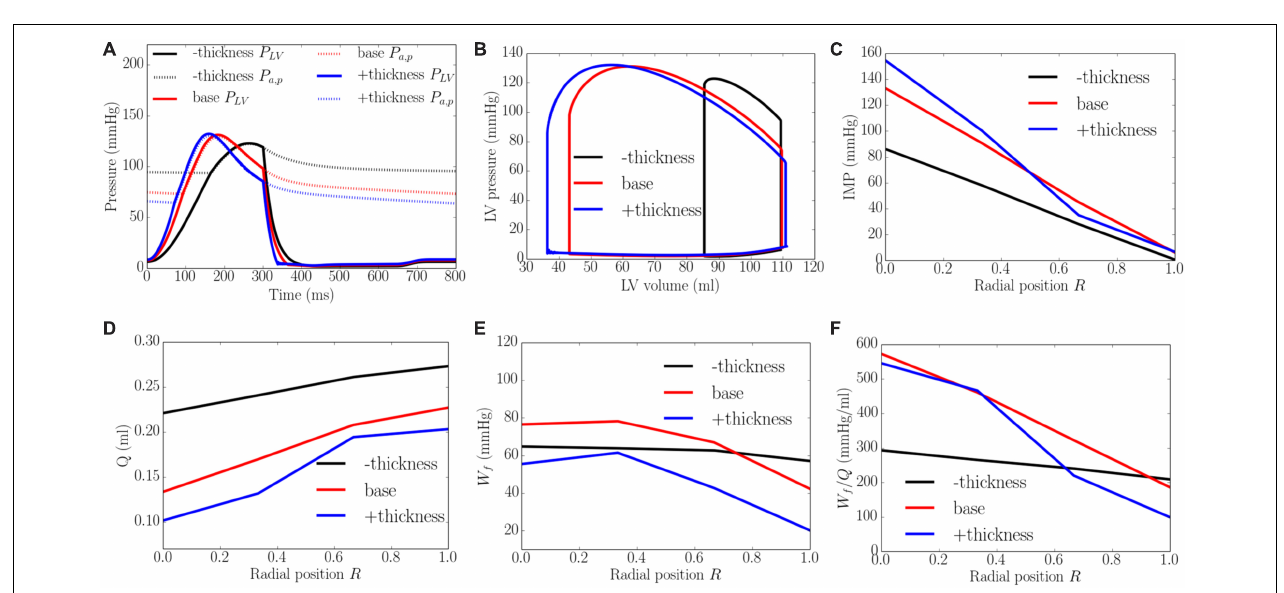
FIGURE 7 | Effects of preload on (A) Pressure waveforms; (B) LV pressure-volume loop; (C) Transmural distribution of IMP; (D) Total coronary flow over a cardiac cycle; (E) Work density over a cardiac cycle W f ; (F) Work density-perfusion mismatch index ratio W f / Q . “-preload,” “base,” and “+preload” denote reduced preload, baseline, and increased preload cases.